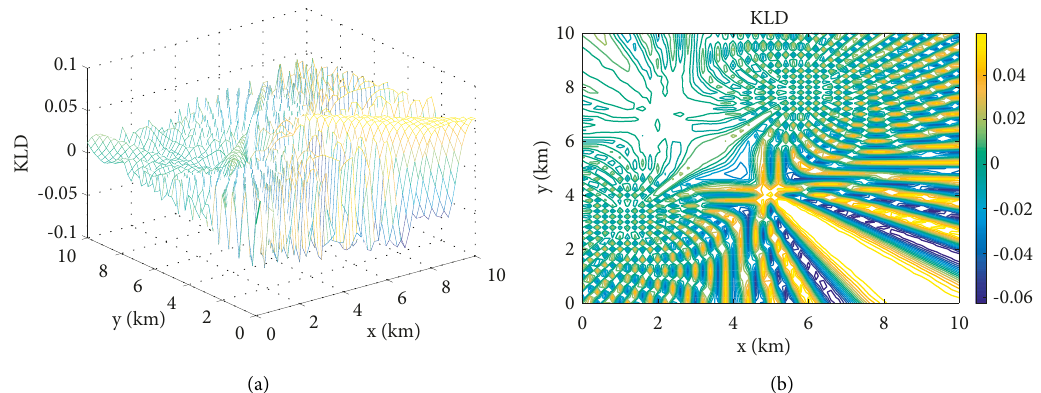
Figure 6: The simulation results when the target’s RCS is 0dBsm. (a) The 3D KLD information distance distribution. (b) The 2D KLD information distance distribution.